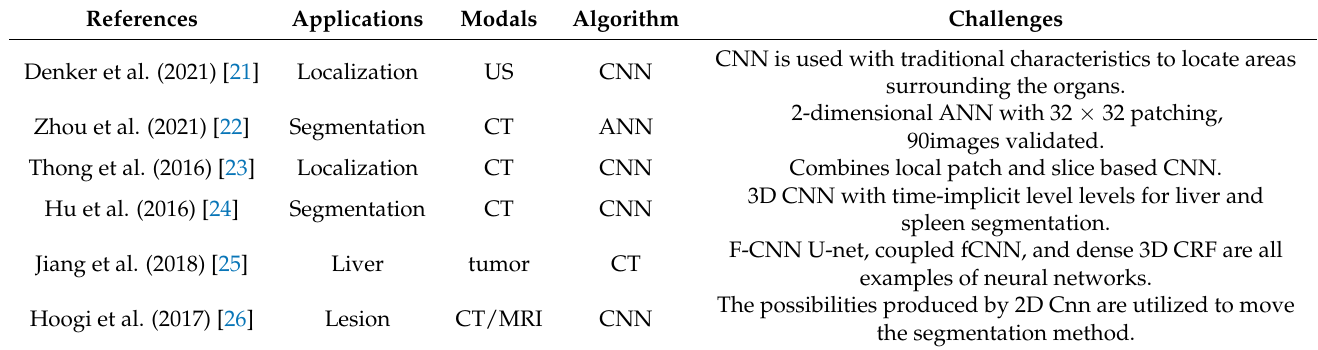
Table 2. Segmentation tasks in kidney imaging.